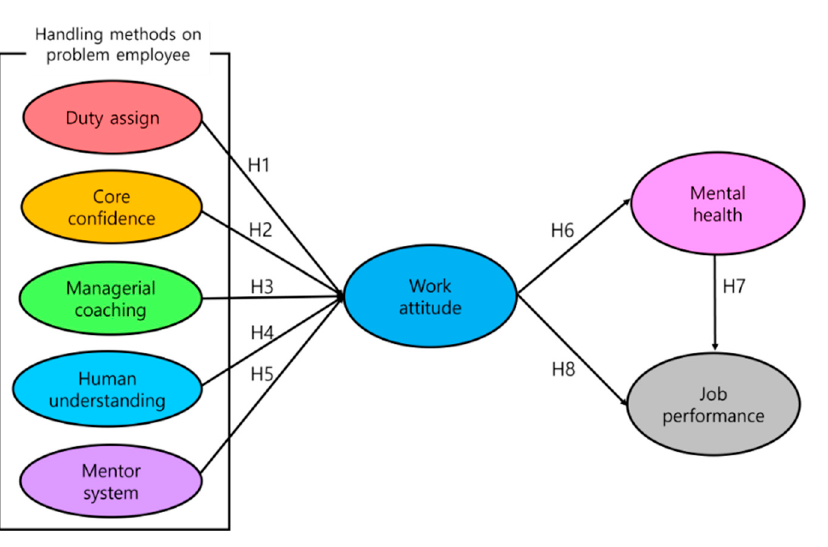
Figure 1. The research